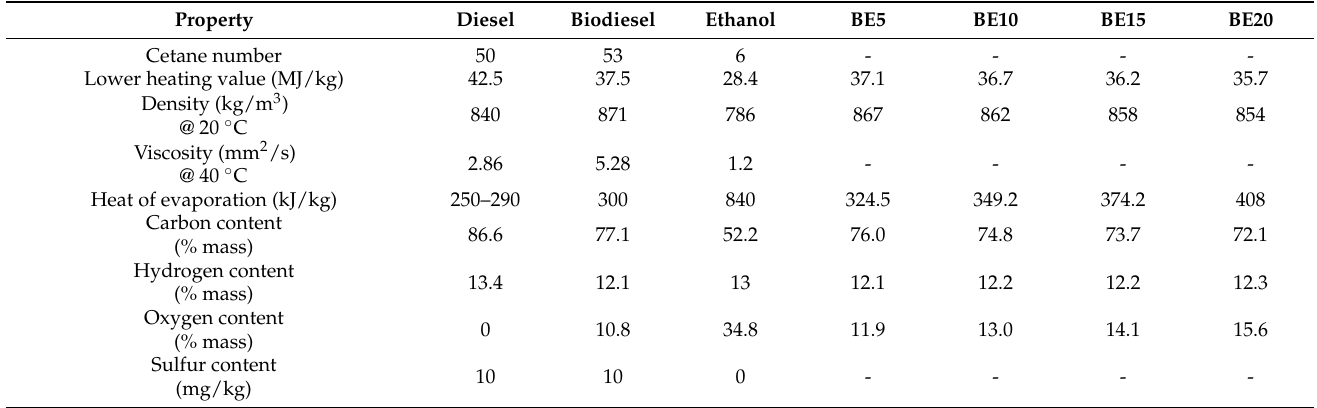
Table 3. Properties of the test fuel.